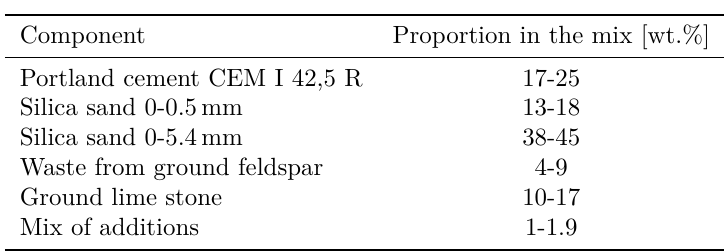
Table 1. Composition of reference mix.